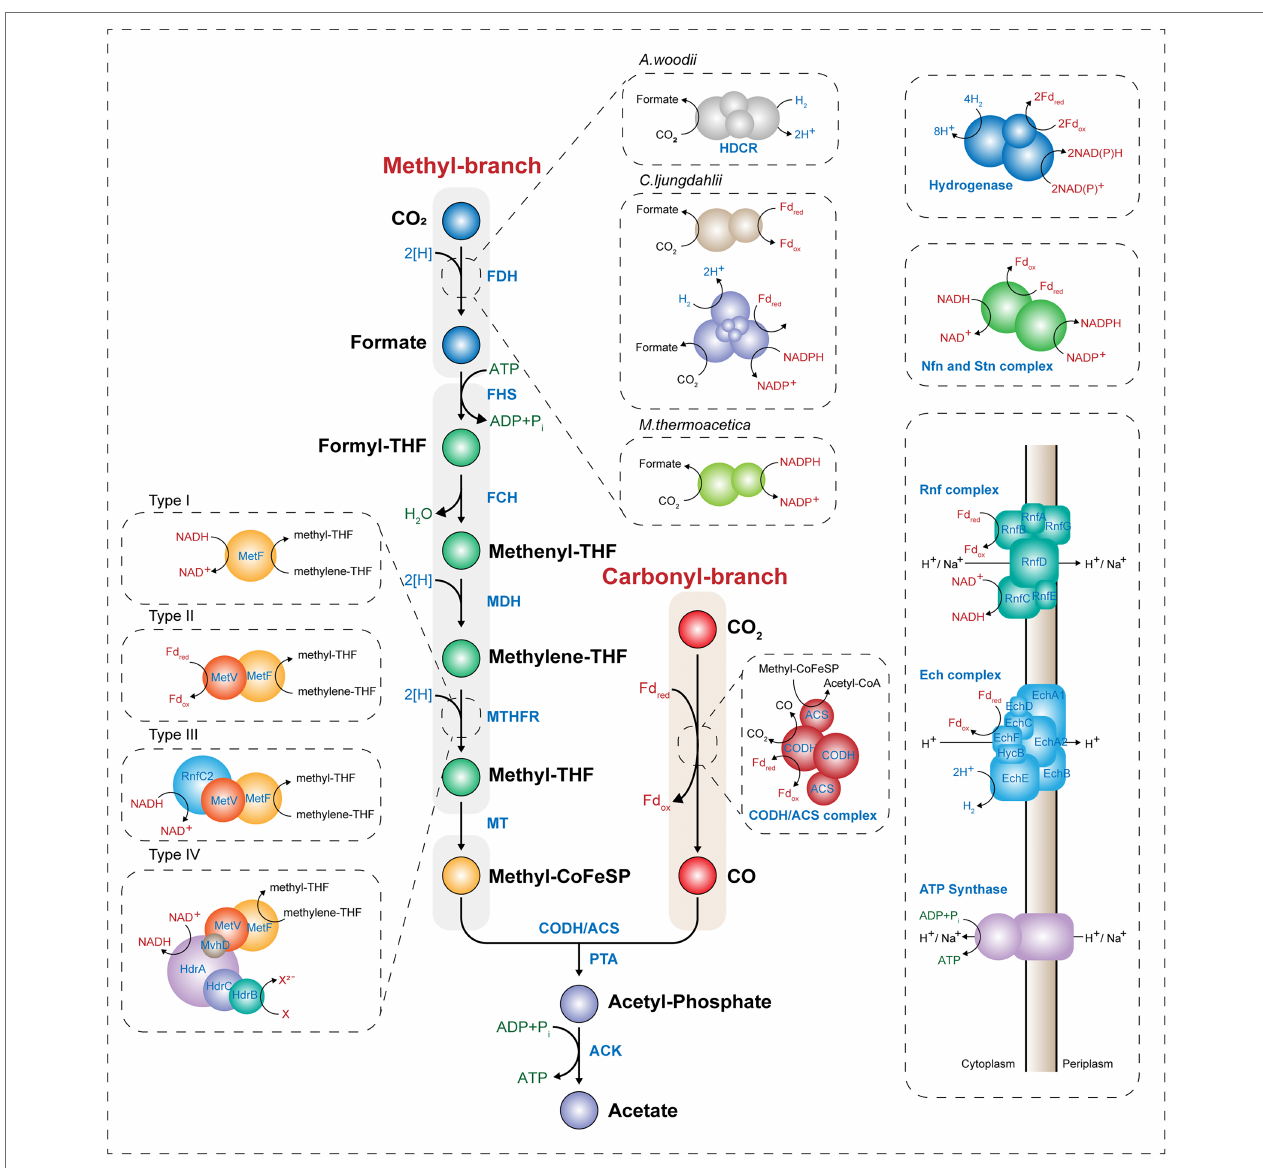
FIGURE 1 | Scheme of the Wood–Ljungdahl pathway and energy conservation. The Wood–Ljungdahl pathway and energy conservation system in acetogens. CO, carbon monoxide; CO 2 , carbon dioxide; THF, tetrahydrofolate; FDH, formate dehydrogenase; FHS, formyl-tetrahydrofolate synthase; FCH, formyl-cyclohydrolase; MDH, methylene-tetrahydrofolate dehydrogenase; MTHFR, methylene-tetrahydrofolate reductase; MT, methyltransferase; CoFeSP, corrinoid iron–sulfur protein; CODH, CO dehydrogenase; ACS, acetyl-CoA synthase; PTA, phosphotransacetylase; ACK, acetate kinase; HDCR, hydrogen-dependent CO 2 reductase; Fd ox , oxidized ferredoxin; Fd red , reduced ferredoxin; and P i , inorganic